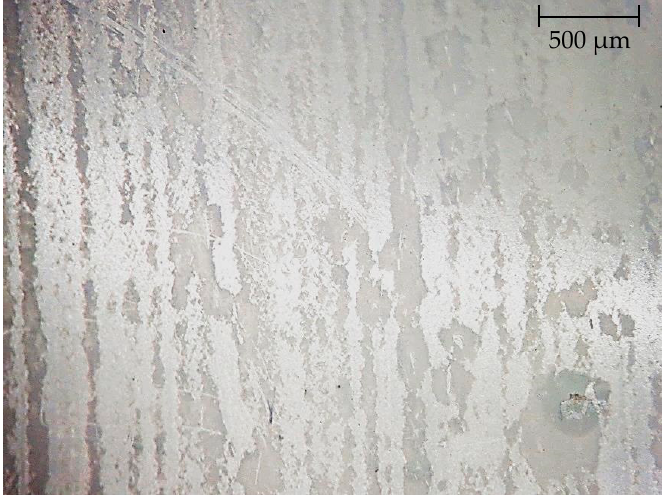
Figure 8. The inner surface of the film with betulin diffused from the film (2.3× magnification). Presumably, the diffusion of the additive takes place mainly in the zones of damage to the polymer integrity during its processing into a multilayer material.